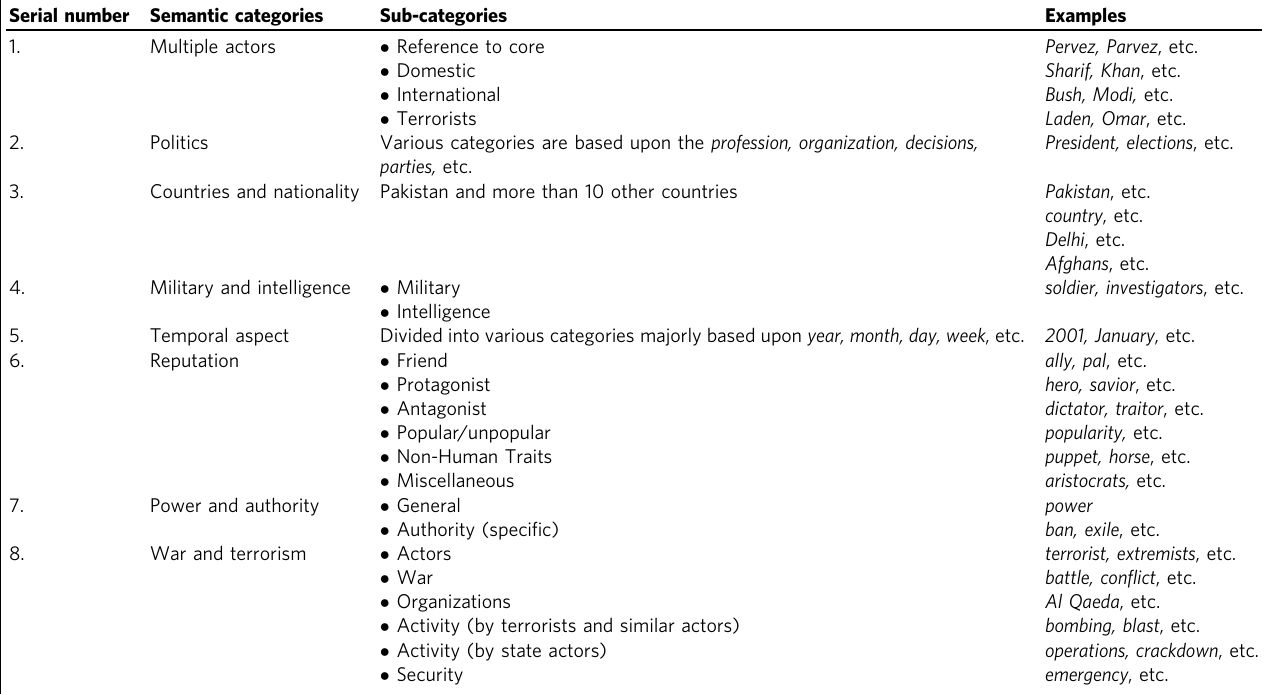
Table 1 Framework for top 8 categories of noun collocates with Musharraf* .